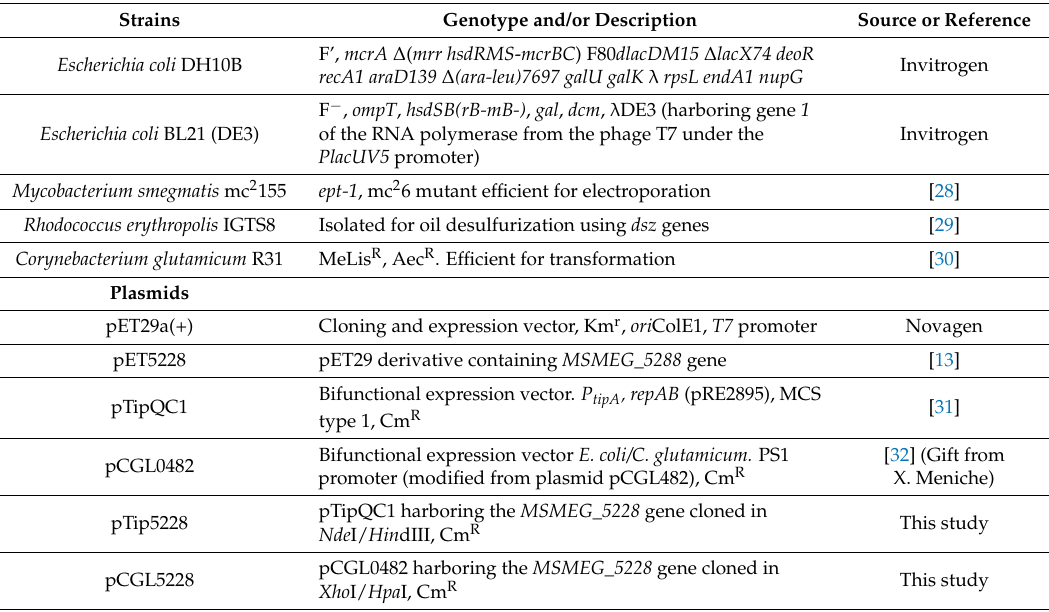
Table 1. Strains and plasmids used in this